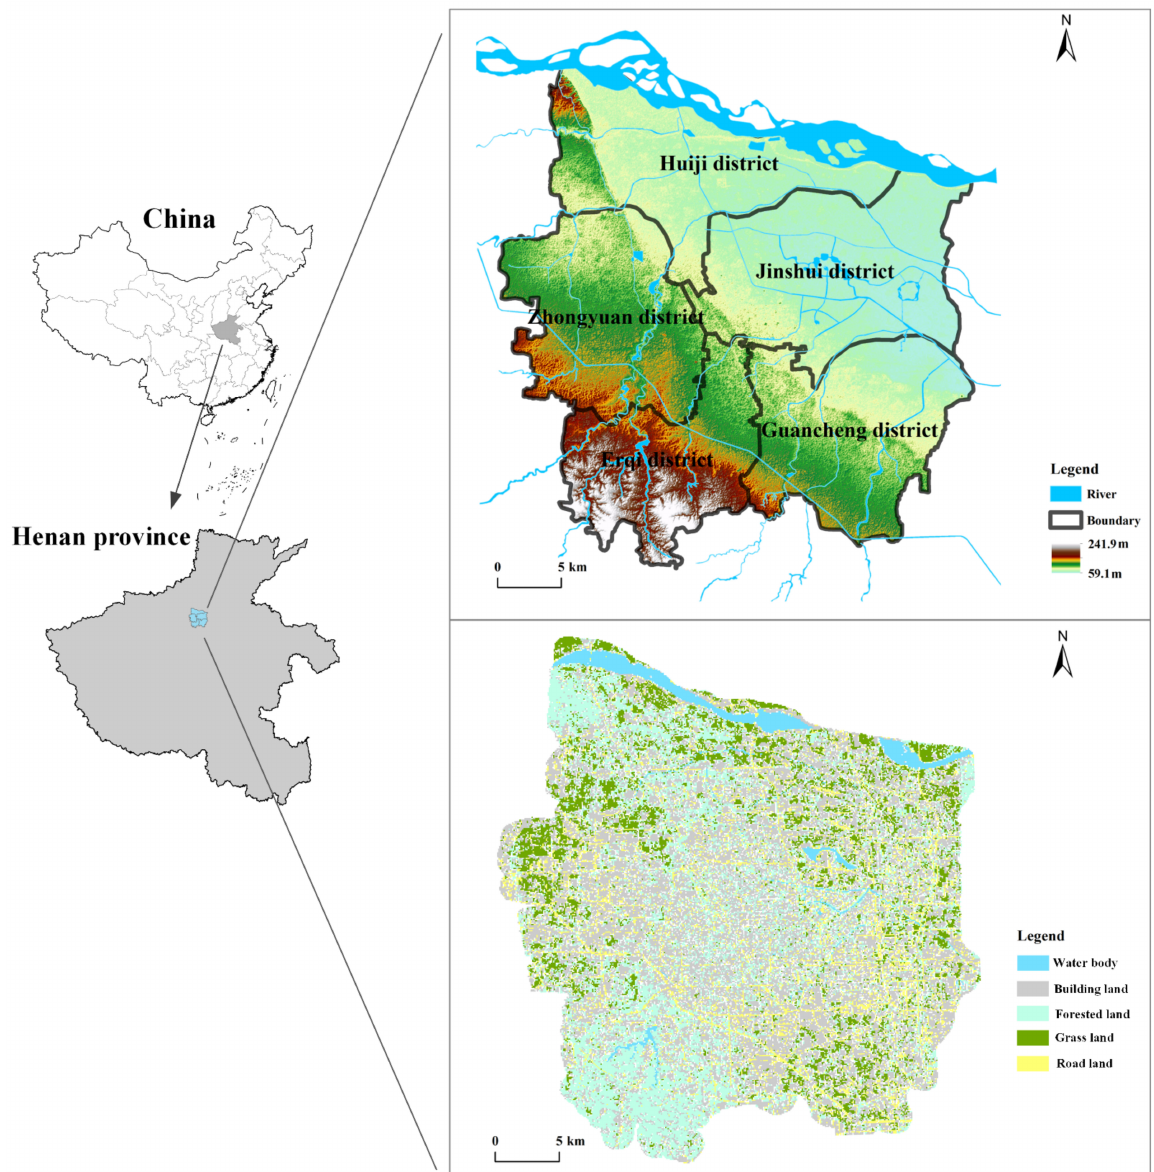
Figure 1. Overview of the study